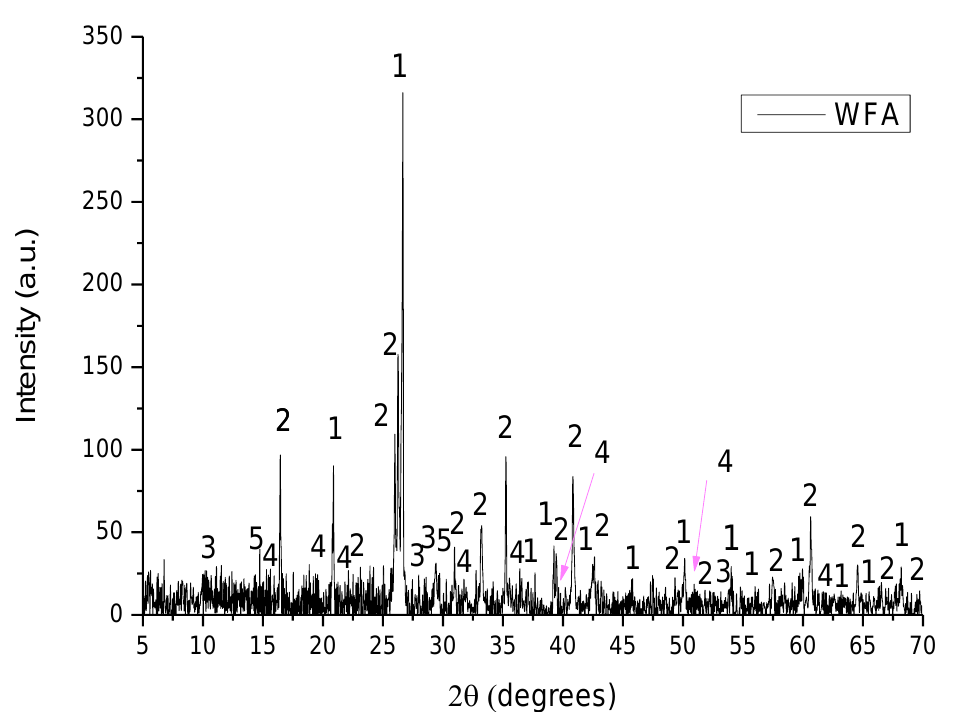
Figure 5. XRD pattern of WFA with Low Pass FFT Filter of wetashka 2_B, where 1: quartz, 2: mullite, 3: indialite, 4: andalusite and 5: potassium silicate.